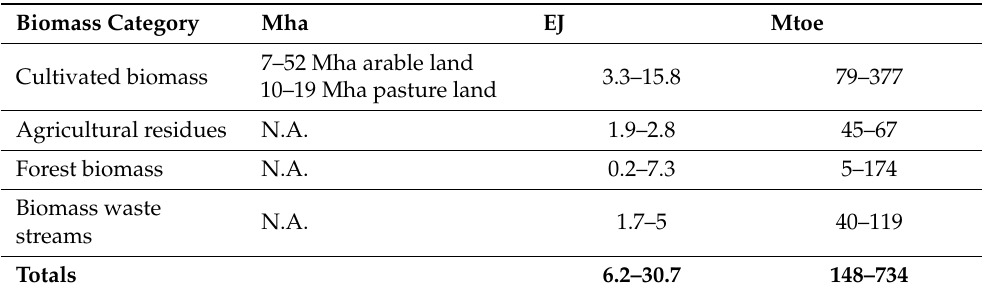
Table 1. Synthesis of European biomass potential. The time frame covers the period 2030–2050 (relevant for RED directive and for 2050 full decarbonization). The relevant geographical zone for the potential is EU-28, including analyses that cover the Ukraine and some other European countries that are not part of the